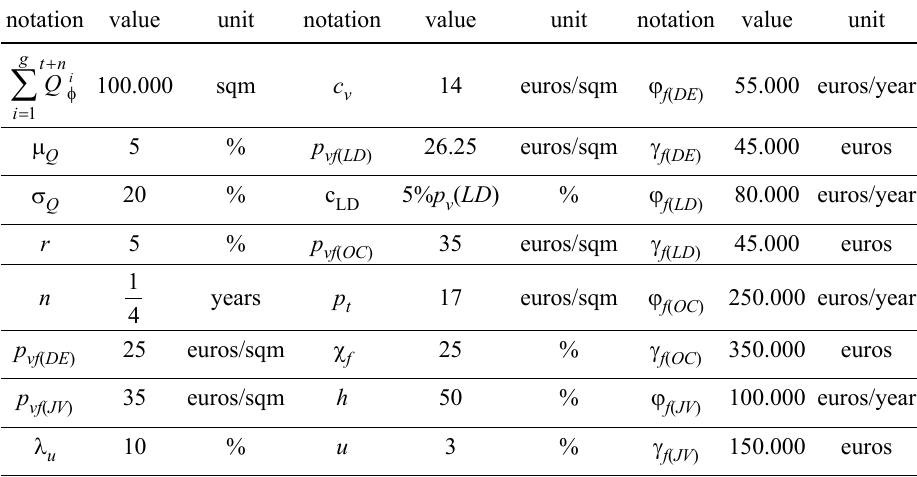
Table 1. Data to support the case